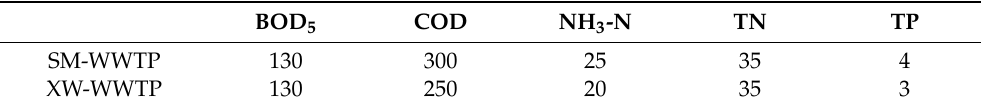
Table 1. Designed influent quality of raw sewage in the wastewater treatment plants examined (unit: mg/L). BOD 5 COD NH 3 -N TN TP SM-WWTP 130